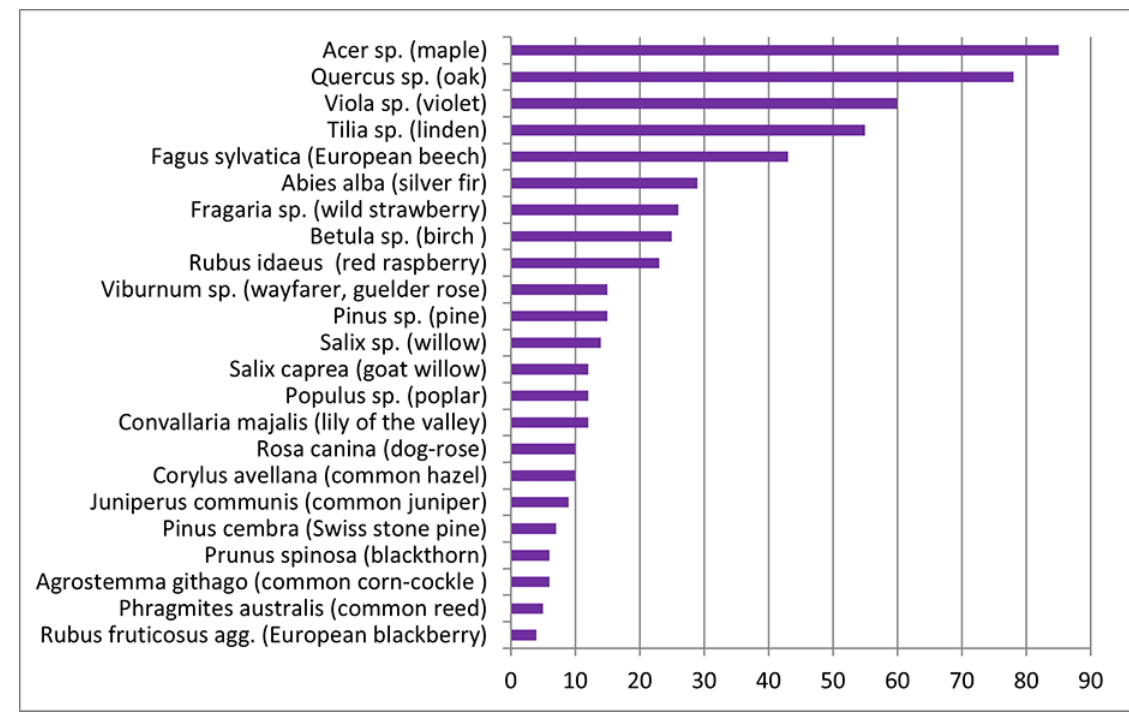
Figure 3 Representation of wild species with a frequency ≥ 4 in Slovak folk songs.